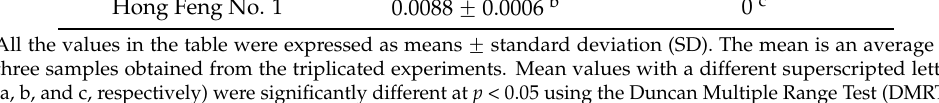
Table 2. Total polyphenolics and flavonoid contents of ethanol extract from Raphanus sativus